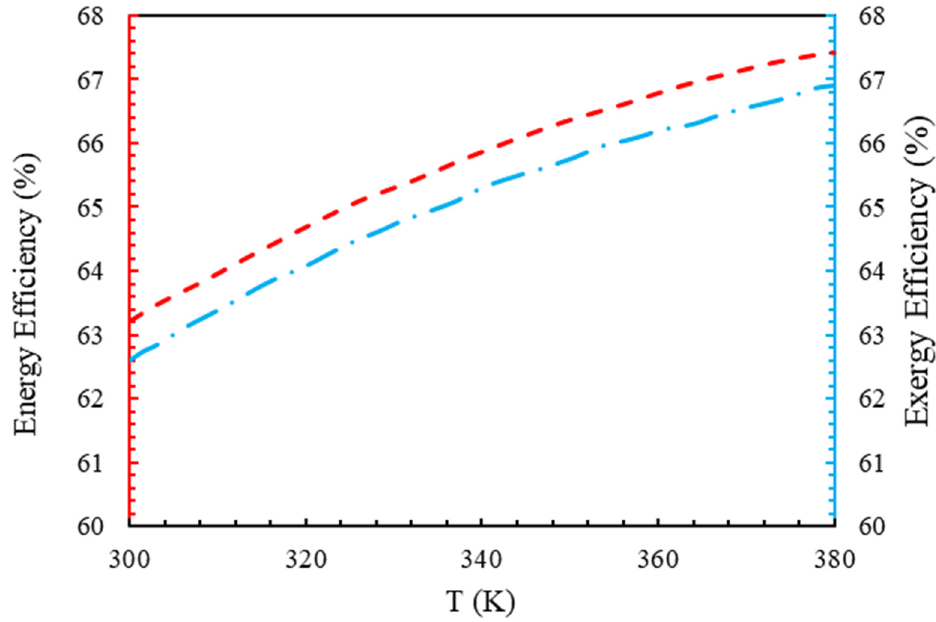
Figure 5. The effect of temperature on the energy and exergy efficiencies at a current density of 5000 A/m 2 .